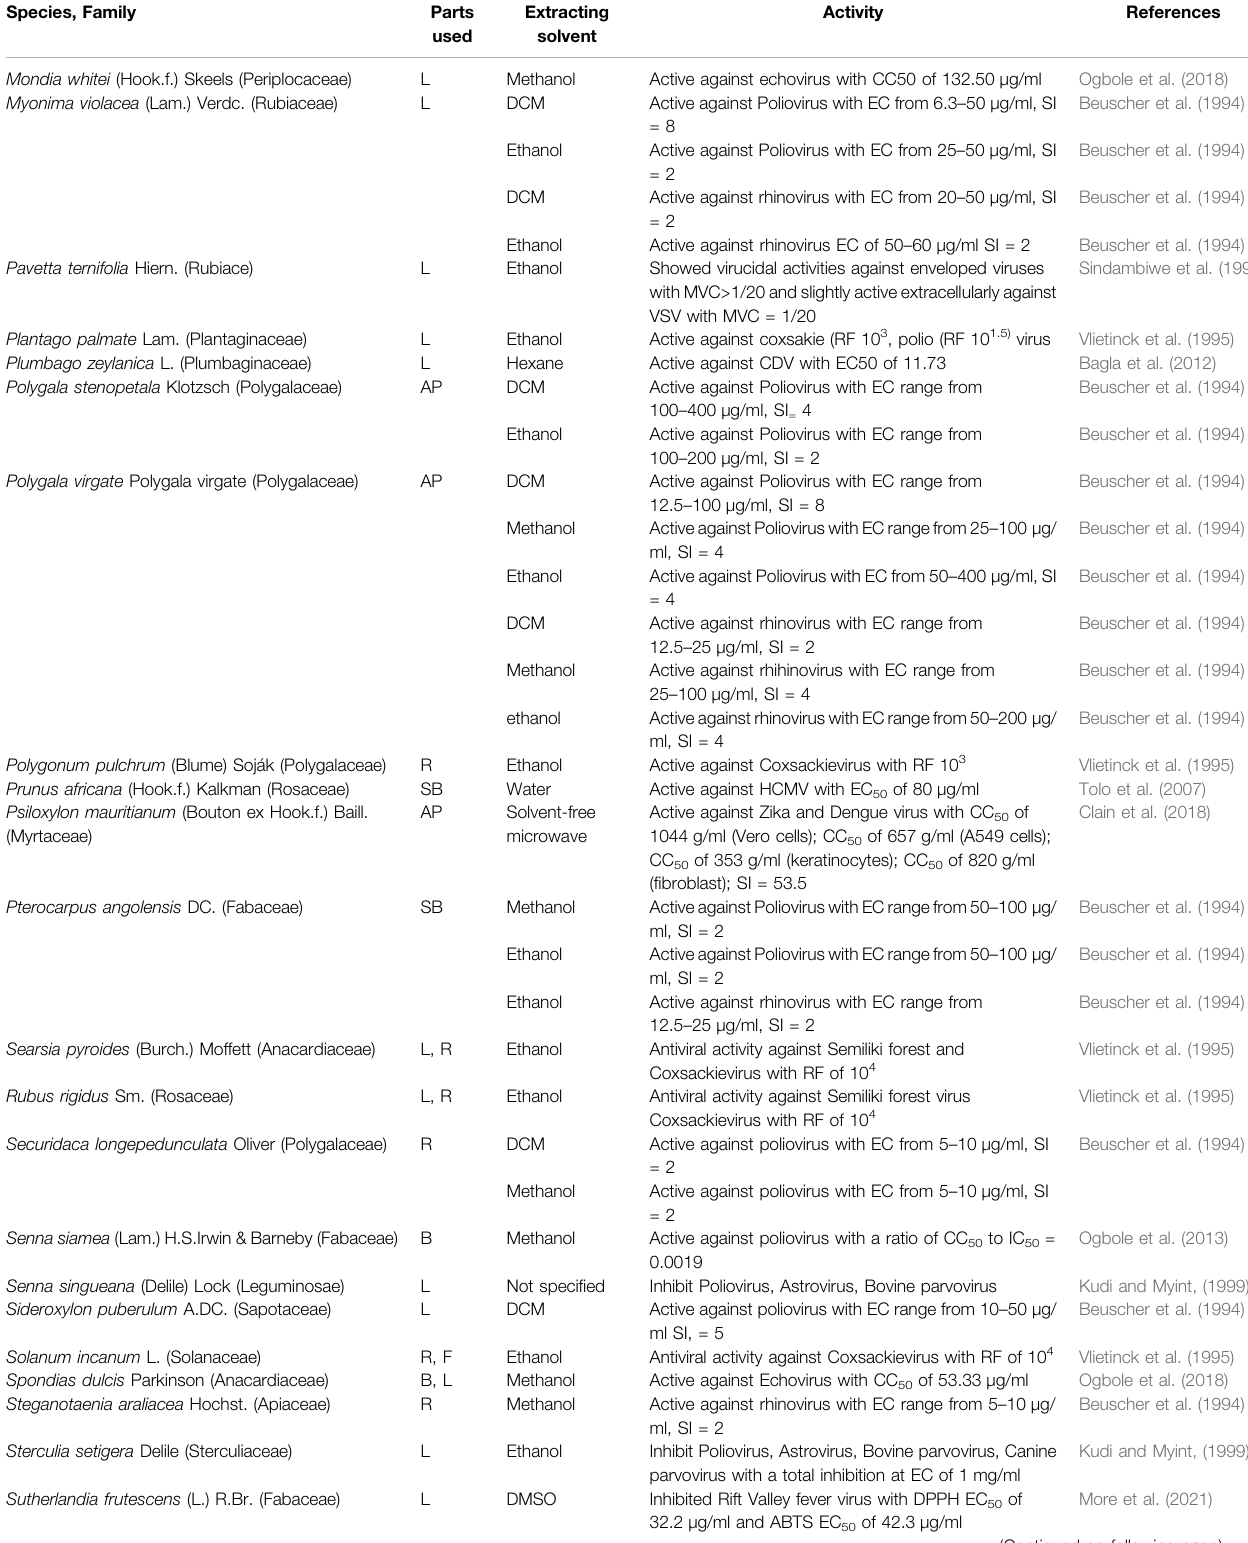
TABLE 4 | ( Continued ) Antiviral activity of African medicinal plants against poliovirus, astrovirus, coxsackievirus, Rift Valley fever virus, zika virus, measle, echovirus, yellow fi ver virus, parvovirus, chikungunya virus, cytomegalovirus, CDV. Species,